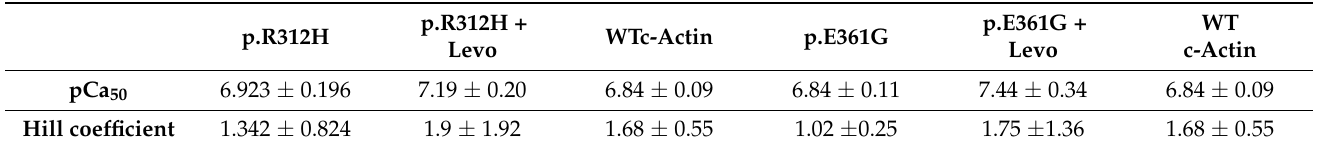
Table 4. Parameters of the myosin-S1 ATPase stimulation by the DCM c-actin mutants p.R312H and E361G in the presence of 20 µ M Levosimendan. Mean values of triplicate experiments. Variations are given as